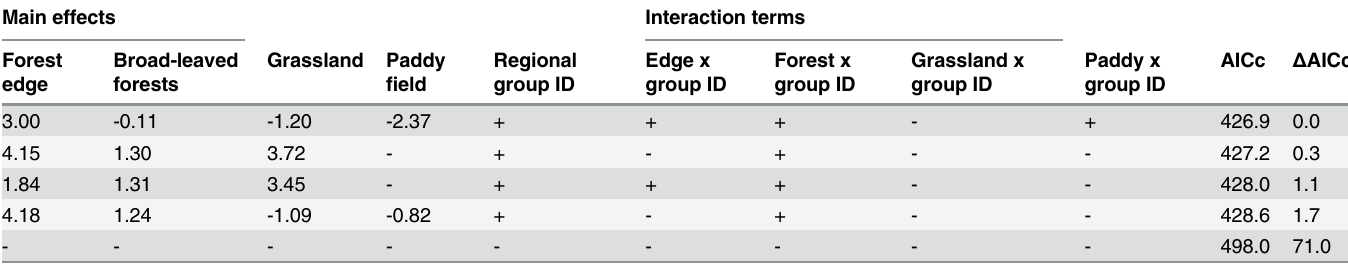
Table 4. Selected models for 3 regional-groups based on landscape similarity (Aichi, Fukuoka-Chiba and Tochigi-Iwate) to explain relationships between buzzard occurrence and landscape elements.